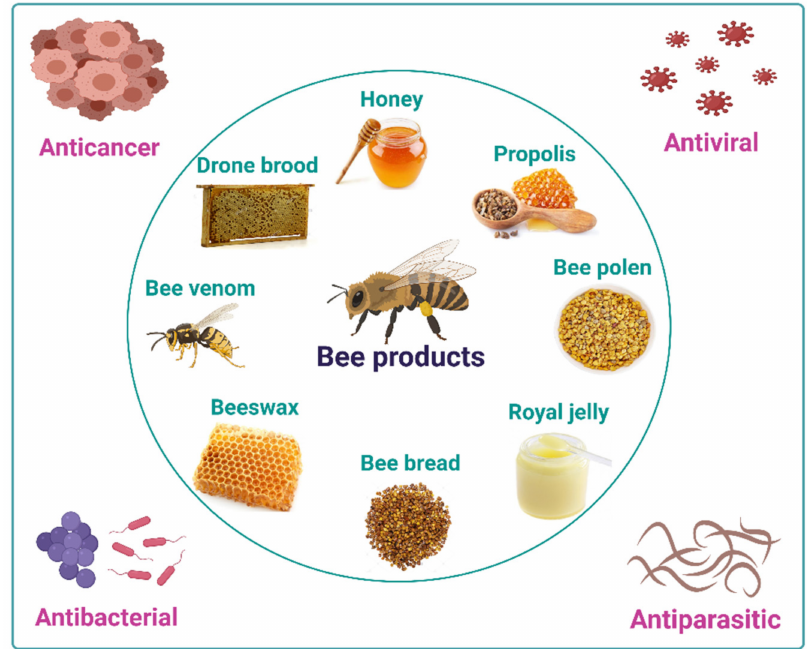
Figure 1. Types of bee